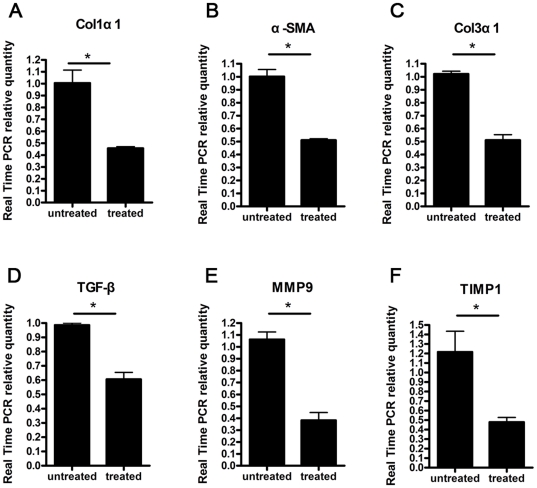
Treatment of prizaquantel for 3 days inhibited expressions of HSC profibrotic genes of mice 12 weeks post infection with Schistosoma japonicum.Prizaquantel (250 mg/kg/day) was administrated to mice for 3 days. Primary HSCs were isolated and transcriptional levels were assessed by Real Time PCR. Transcriptional level of (A) Col1α1, (B) α-SMA,(C) Col3α1, (D) TGF-β, (E) MMP9 and (F) TIMP1 in HSC of treated mice were significantly reduced compared with untreated mice. (* p<0.05).